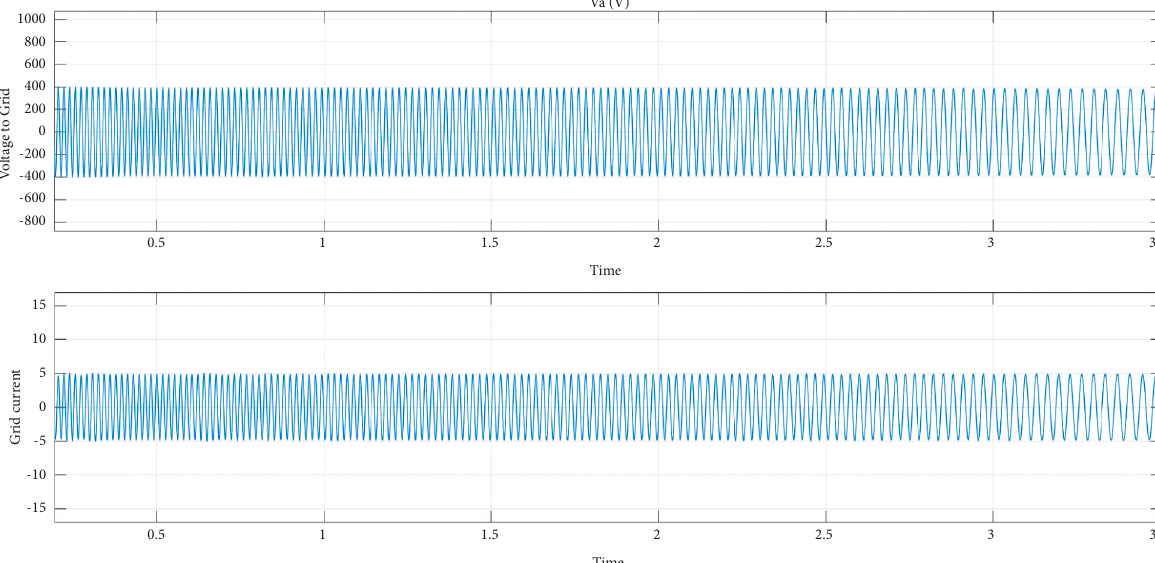
Figure 8: System outputs with modified P and O method: system voltage and